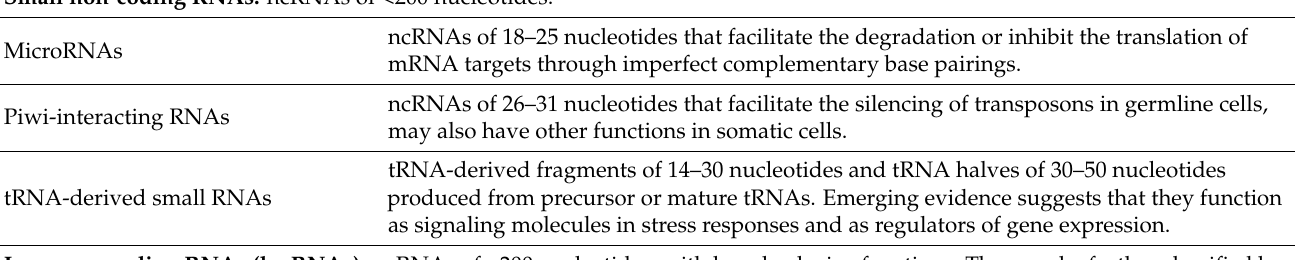
Table 1. Different classes of